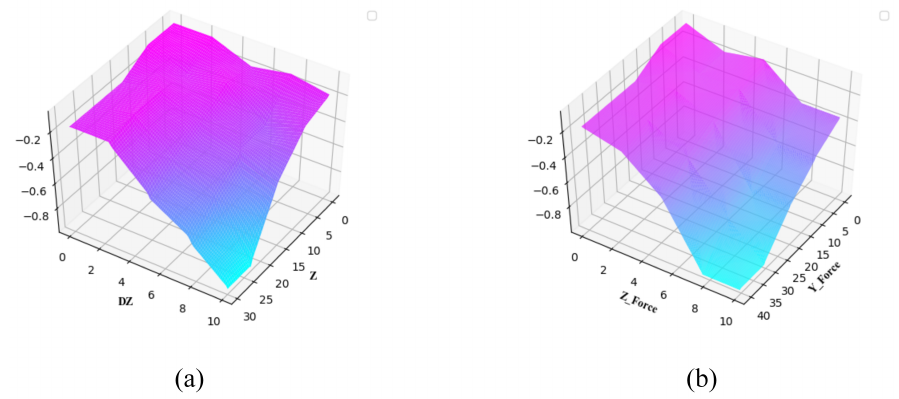
Figure 7. The first layer of fuzzy logic system output: ( a ) F y − F z fuzzy logic system output value; ( b ) Z − D Z fuzzy logic system output